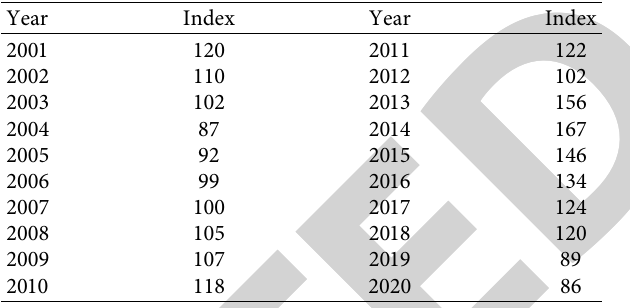
Table 3: The company’s economic development index in the past 20